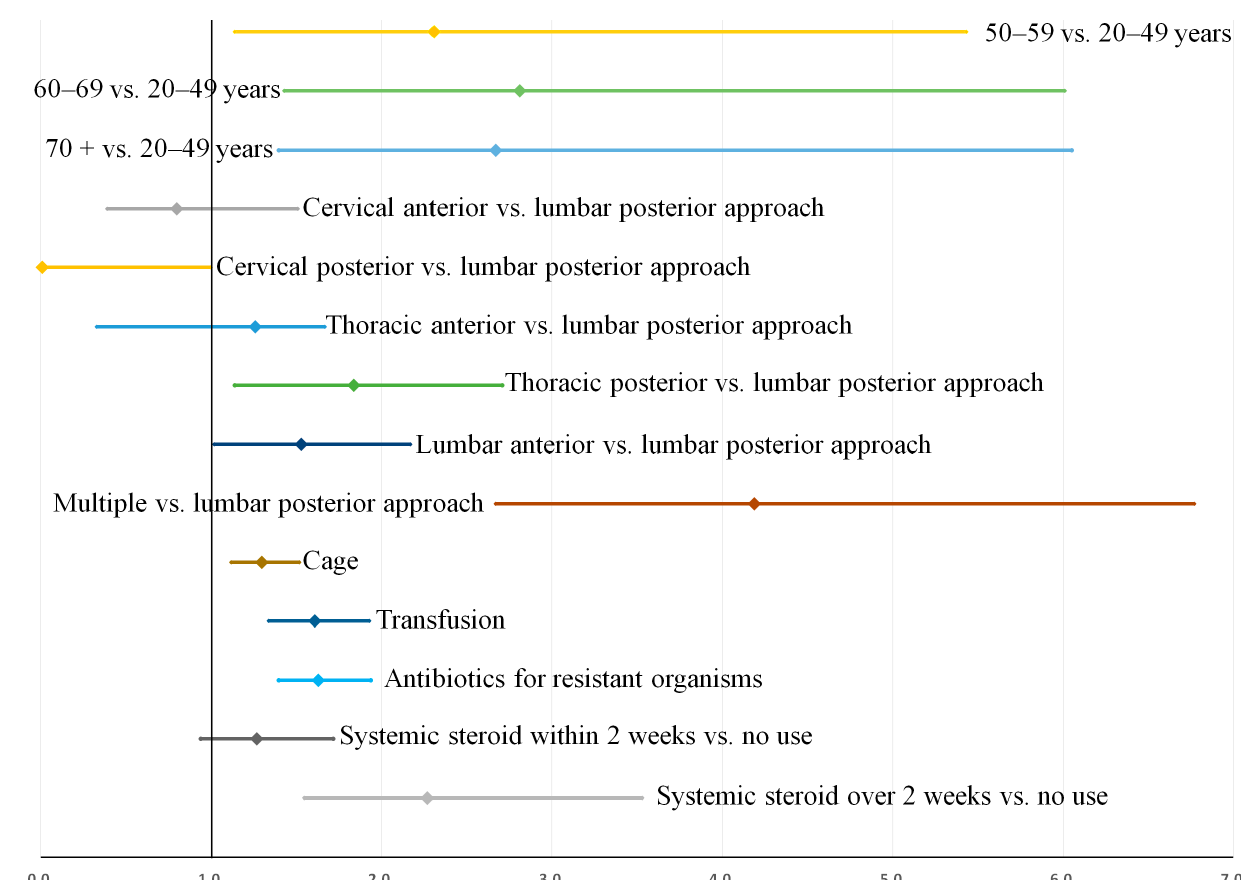
Figure 7. Associated factors for recurrence when recurrence was defined as an infection requiring over 6 weeks of antibiotic treatment: Bootstrap-adjusted odds ratios and their 95% confidence inter- vals (Supplementary Table S7).